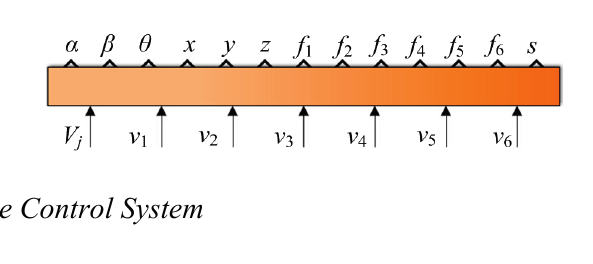
Figure 8. The control module of the LIDM in MATLAB.